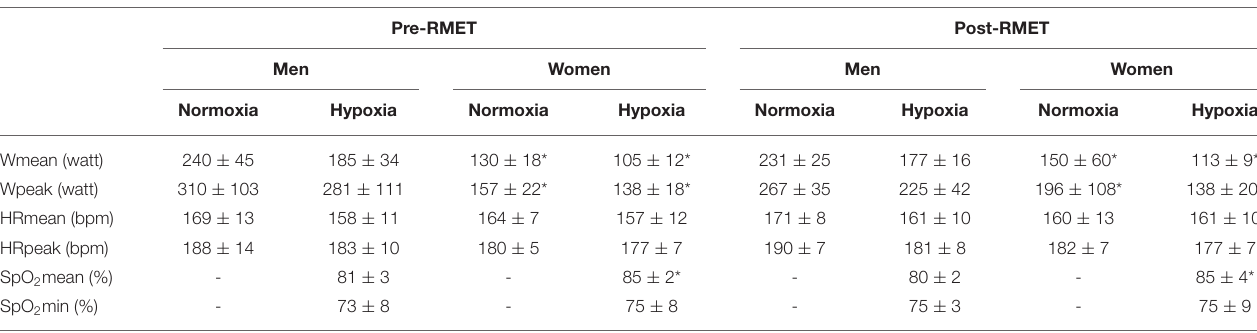
TABLE 2 | Parameters monitored during the 10-km cycling time